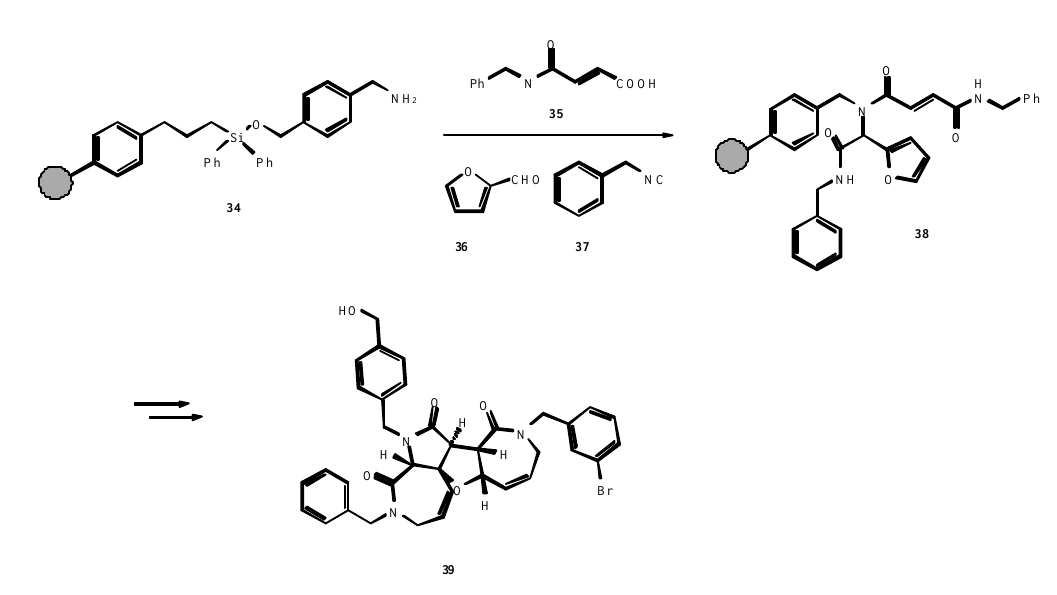
Scheme 10 : Solid phase synthesis of a polycyclic system employing a U-4CR.